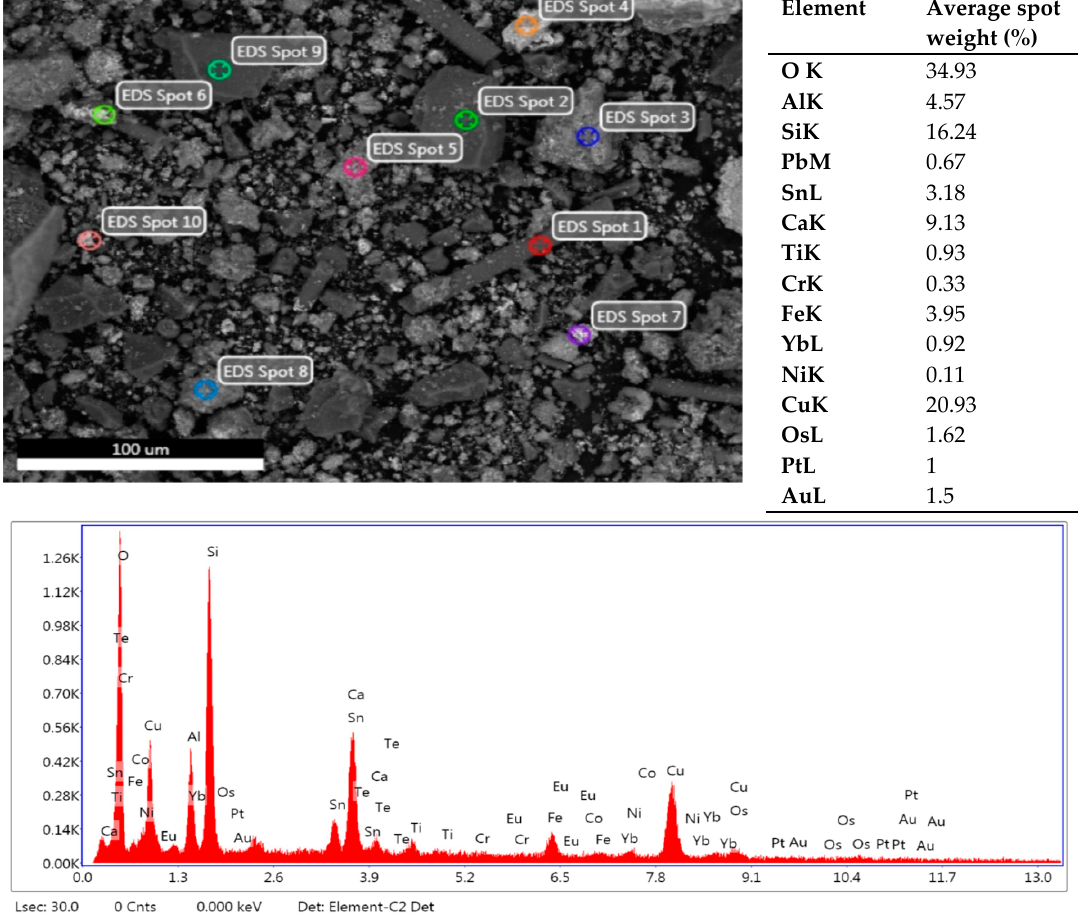
Figure 3. The scanning electron microscopy (SEM-EDX) of PCBs powder sample.